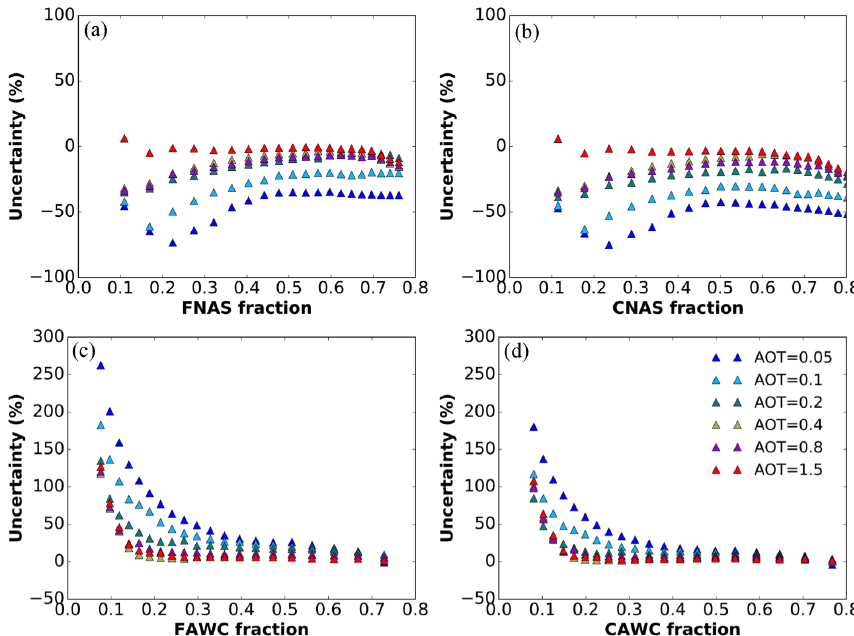
Figure 8. Uncertainty in the non-absorbing soluble particles and aerosol water content fraction in the fine (FNAS, FAWC) and coarse (CNAS, CAWC) modes attributed to the refractive index and hygroscopic properties of ammonium nitrate and ammonium